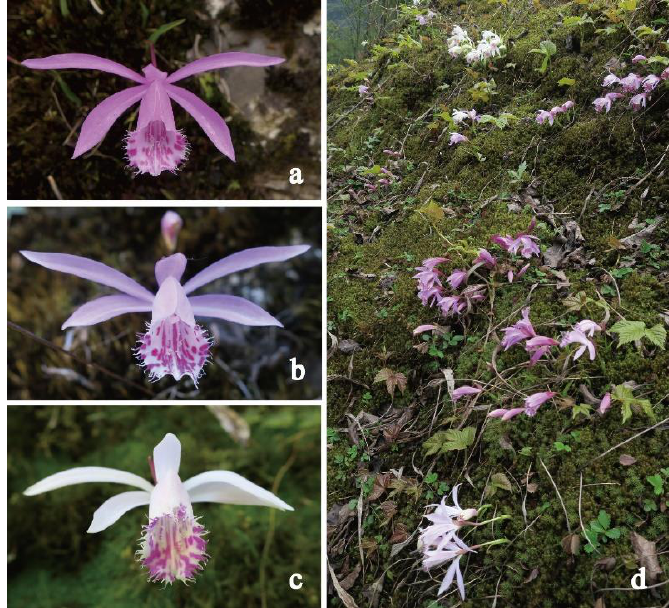
Figure 10. Flower polymorphism of Pleione limprichtii in Huanglong population. ( a ) rose-purple flower; ( b ) pink flower; ( c ) white flower; ( d ) one of the polymorphic populations on a rock.